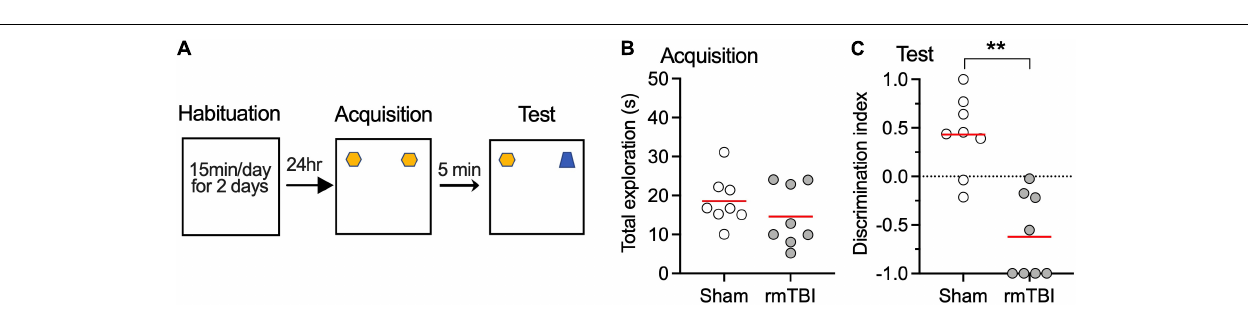
FIGURE 7 | rmTBI on rats in novel object recognition test. (A) Scheme of the NOR test. (B) Rats with sham injury and rats with mTBI show similar exploration time in training session. Rats with rmTBI show lower discrimination index than sham injury control (C) on the novel object in testing session. ** P < 0.01 by t -test. Each dot represents data from one